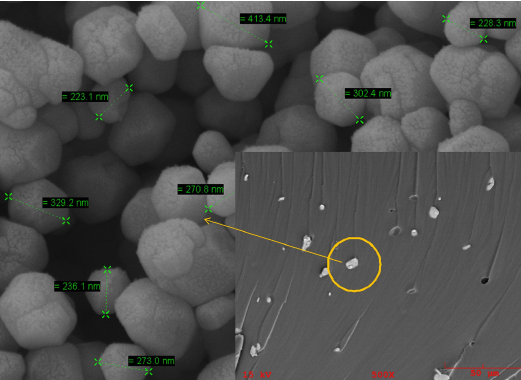
Figure 3. SEM micrographs of the photocured materials containing AgPNs.